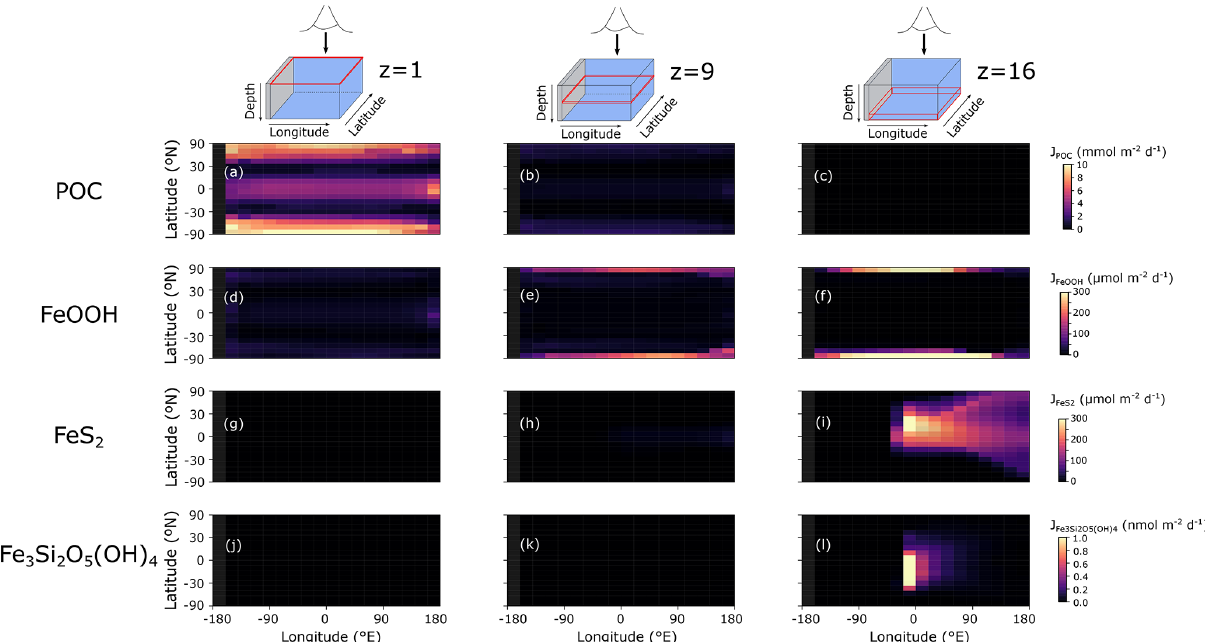
Figure 7. Model output of (a) – (c) particulate organic carbon flux ( J POC ), (d) – (f) solid-iron oxide flux ( J FeOOH ), (g) – (i) pyrite flux ( J FeS and (j) – (l) greenalite flux ( J Fe ) for an ocean with 50% of the modern phosphate inventory. J POC is given in mmolm − 2 d − 1 , 3 Si 2 O 5 ( OH ) 4 J FeOOH and J FeS are given in µmolm − 2 d − 1 , and J Fe is given in nmolm − 2 d − 1 . The siderite flux ( J FeCO 2 3 Si 2 O 5 ( OH ) 4 everywhere and is not shown here.